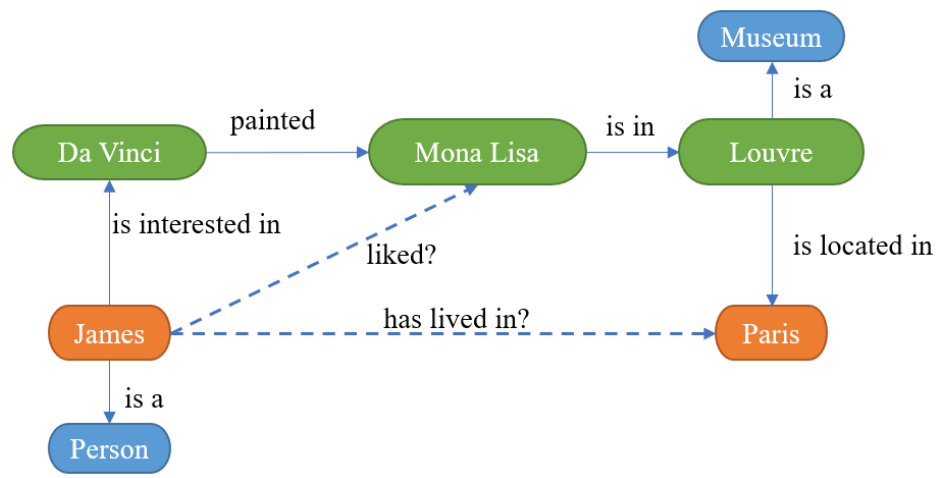
Figure 1. Example of an incomplete knowledge graph which contains missing links (dashed lines) that can possibly be inferred from existing facts (solid